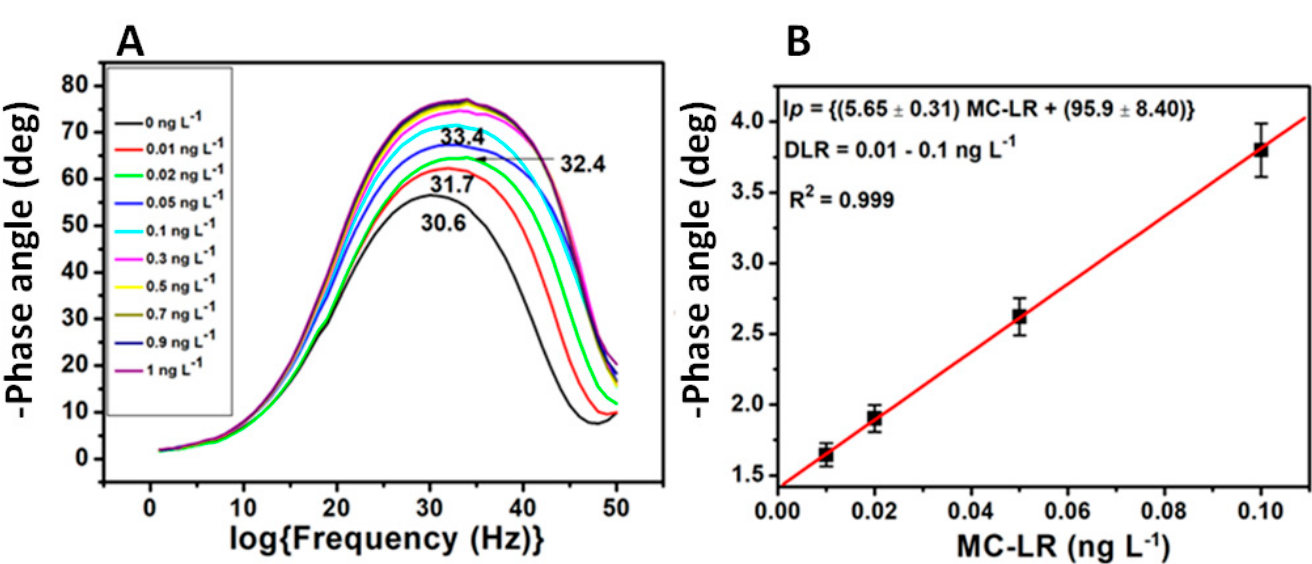
Figure 11. MC-LR aptasensor (GCE|PDMA–PVS–Ag 0 |SH-Apt): ( A ) Bode phase angle response profile, and ( B ) linear calibration graph (numbers on the plots in graph A are the log(frequency) values corresponding to - Φ (maximum) ).